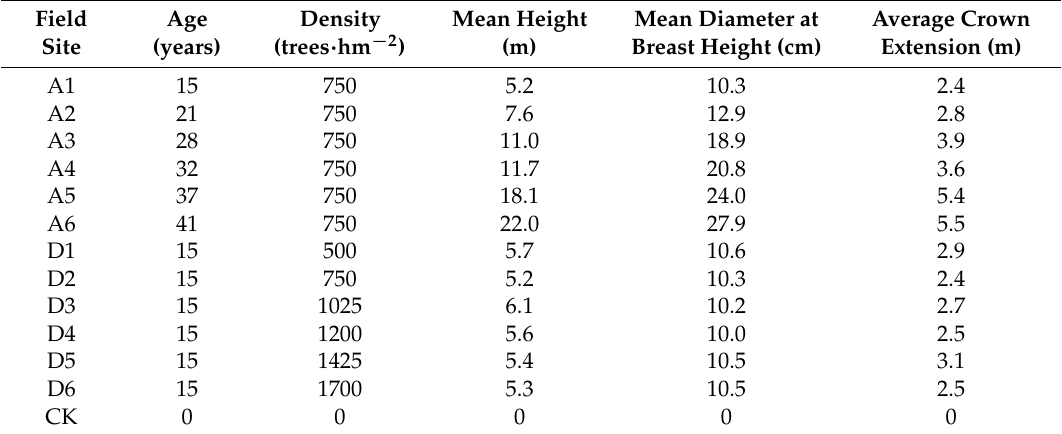
Table 1. Summary of the basic conditions of the forest sites and the unforested control site in Zhangbei County, Hebei Province,